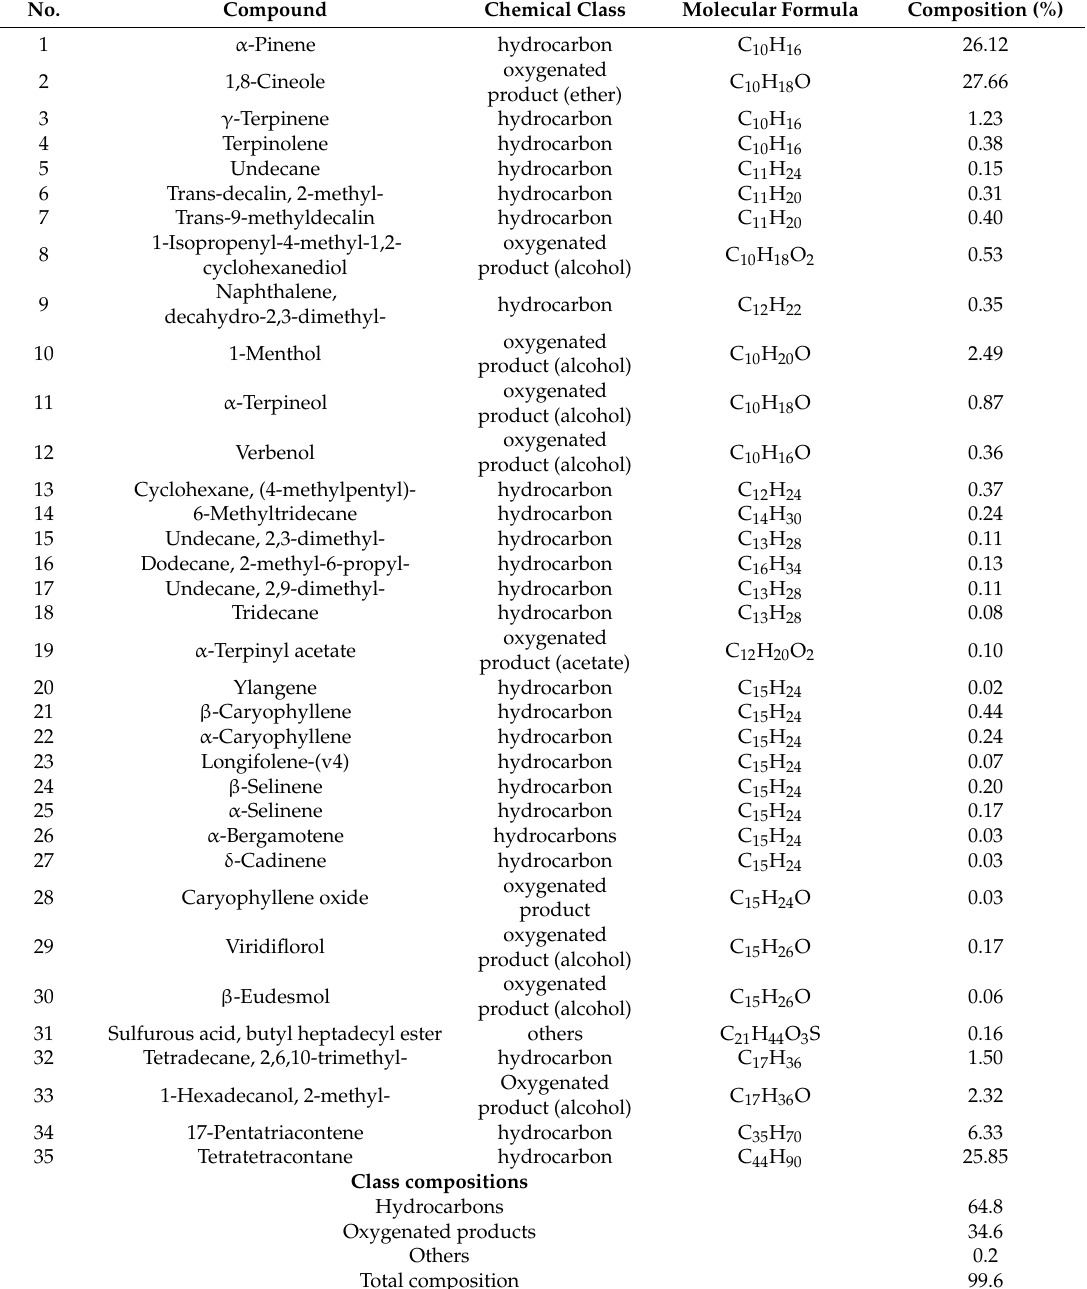
Table 2. List of compounds identified by gas chromatography mass spectrometry (GC-MS) analysis.